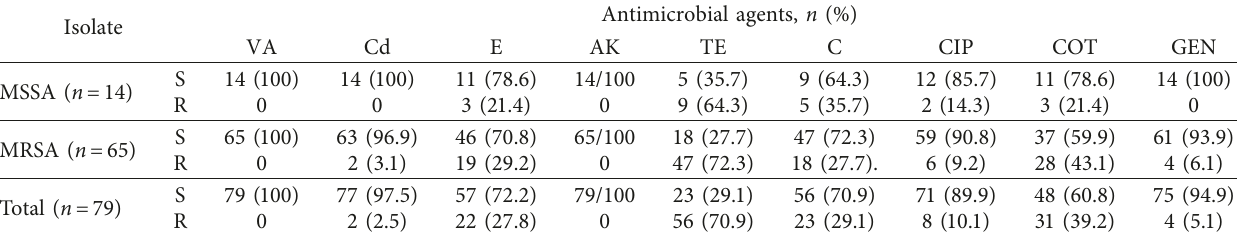
Antimicrobial agents, n